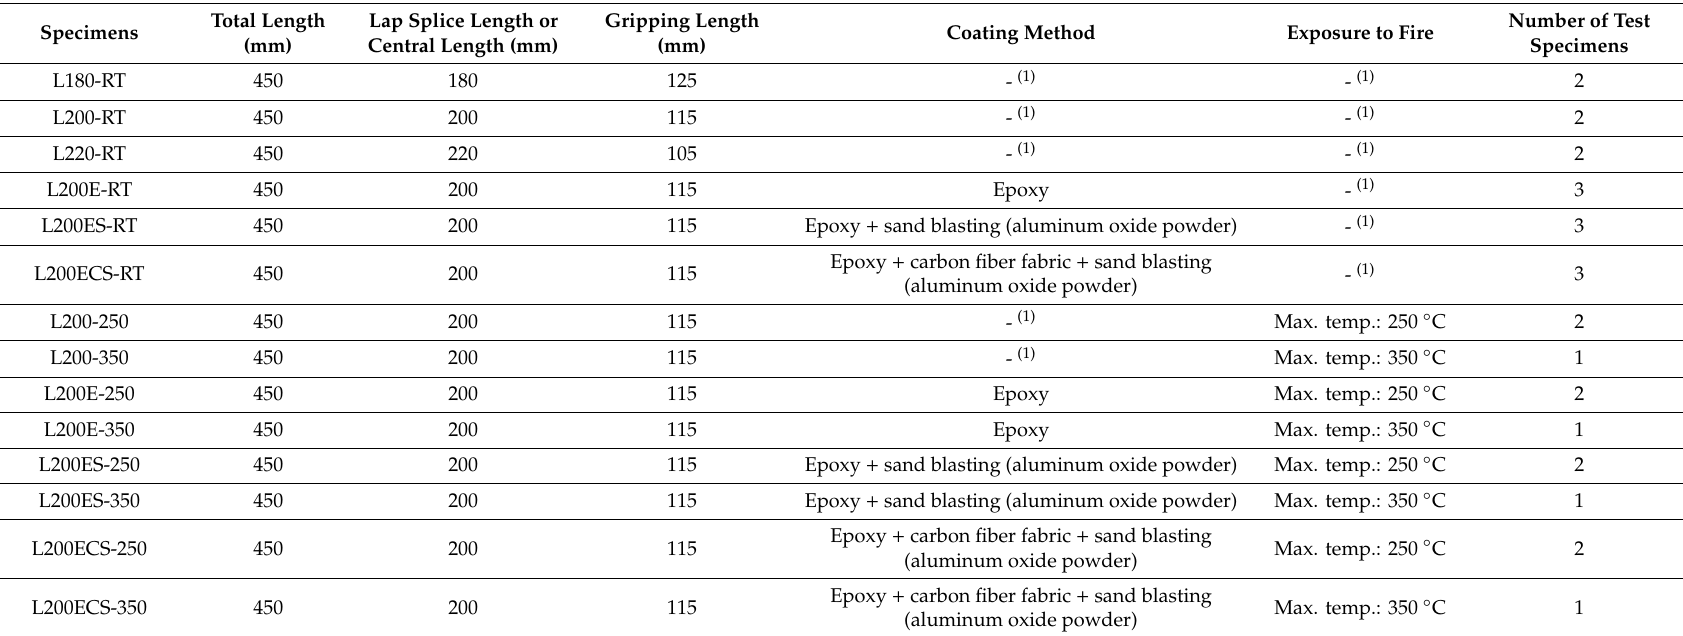
Table 1. Properties of TRM specimens in this